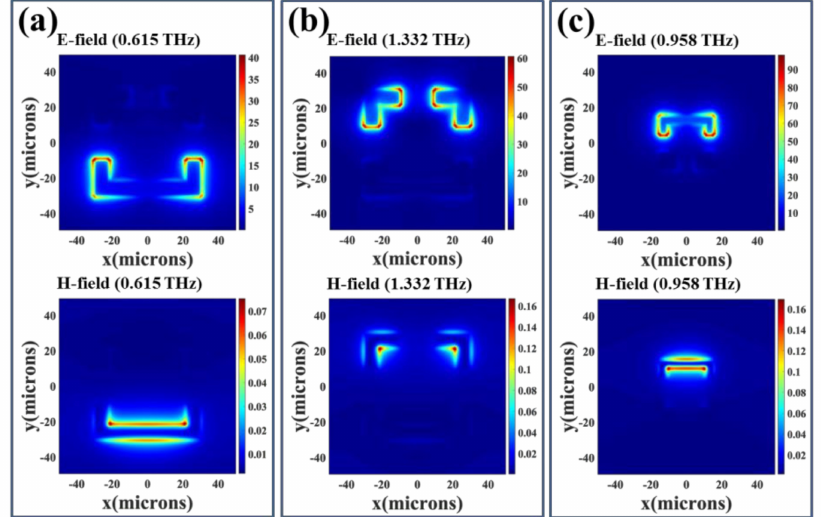
Figure 5. E- and H-field distributions of SRR-3 and SRR-4 with h = 0 µ m. They are ( a ) SRR-3 monitored at f = 0.615 THz; ( b ) SRR-3 monitored at f = 1.332 THz and ( c ) SRR-4 monitored at f = 0.958 THz;